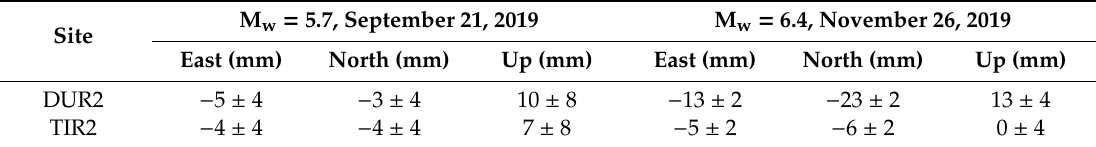
Table 3. Co-seismic displacements produced by the September 21, 2019 and November 26, 2019 earthquakes at the AlbPOS GNSS stations DUR2 and TIR2 (Figure